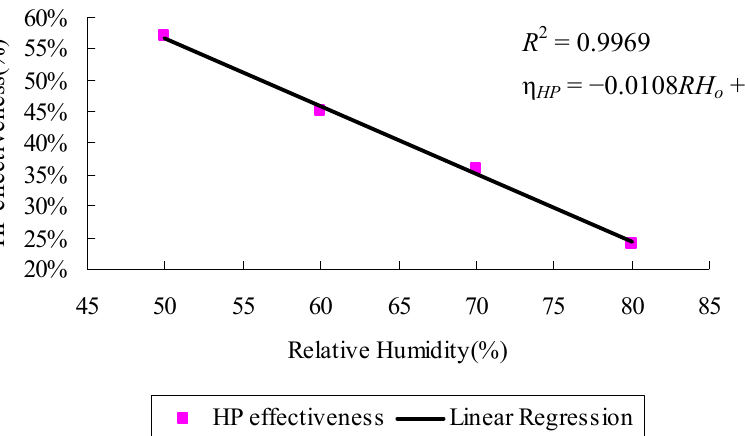
Figure 12. HP effectiveness of various